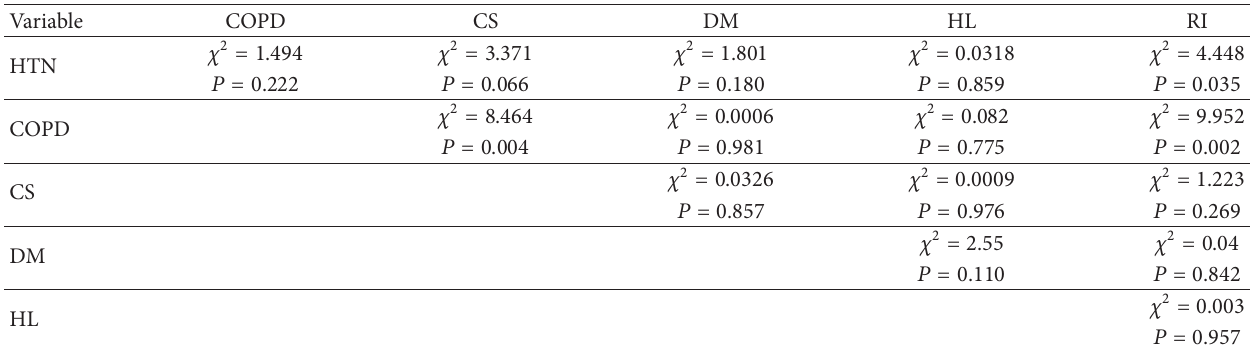
Table 3: 𝜒 2 analysis of risk factors.